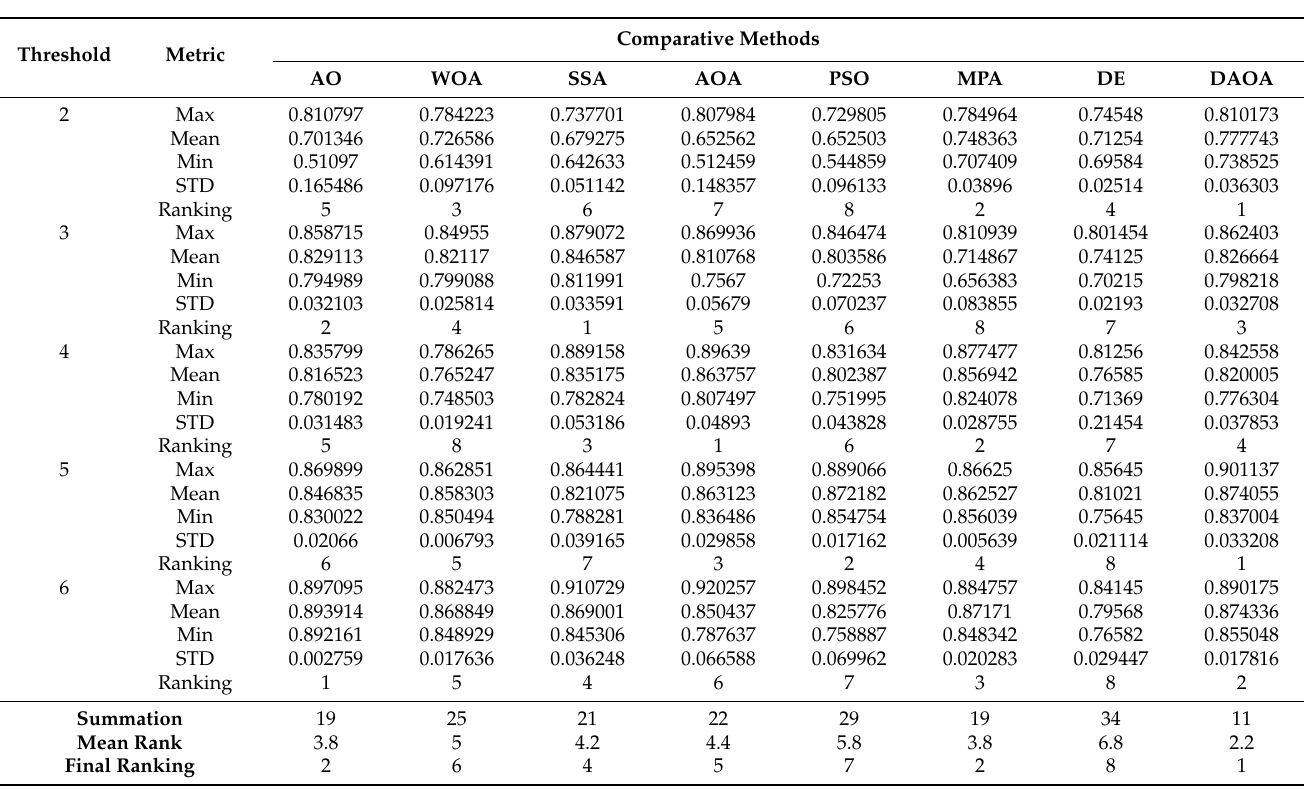
Table 7. The SSIM results of the test case